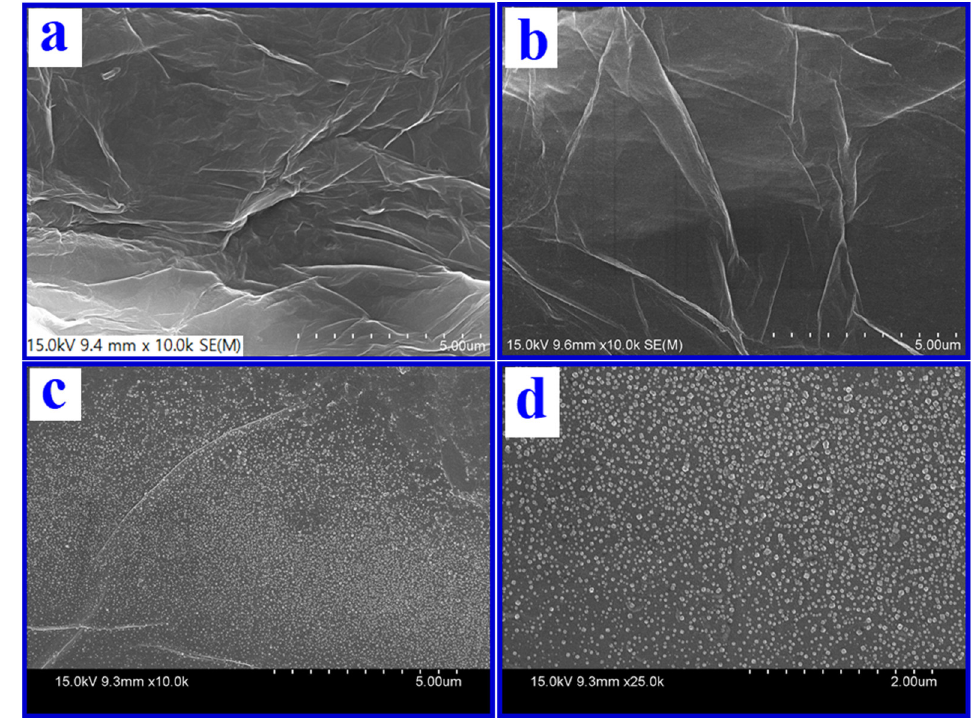
Figure 2. FESEM images of ( a ) GO/GC, ( b ) ERGO/GC, and ( c , d ) p-CFA@ERGO/GC low and high magnifications.